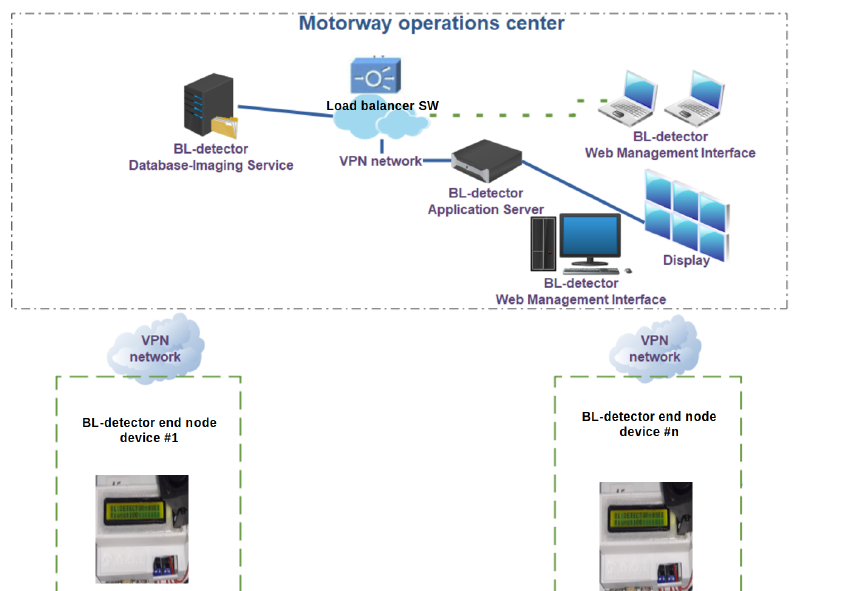
Figure 1. BL-detection system high-level architecture.